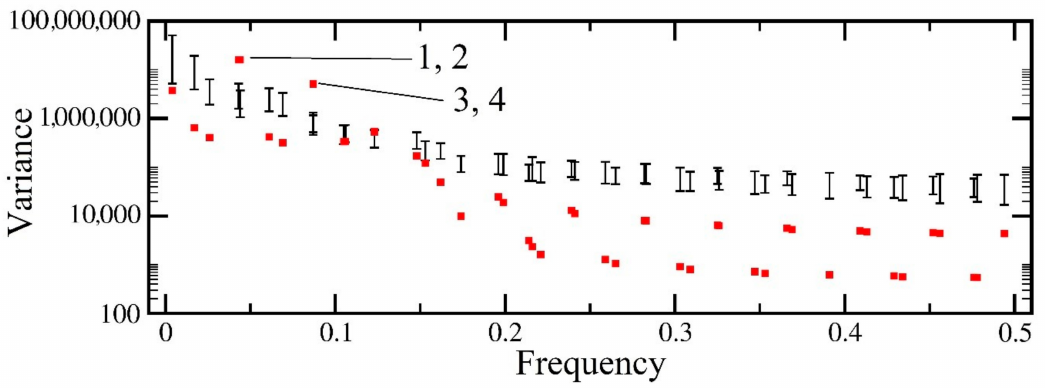
Figure 8. Monte Carlo SSA based on data EOFs